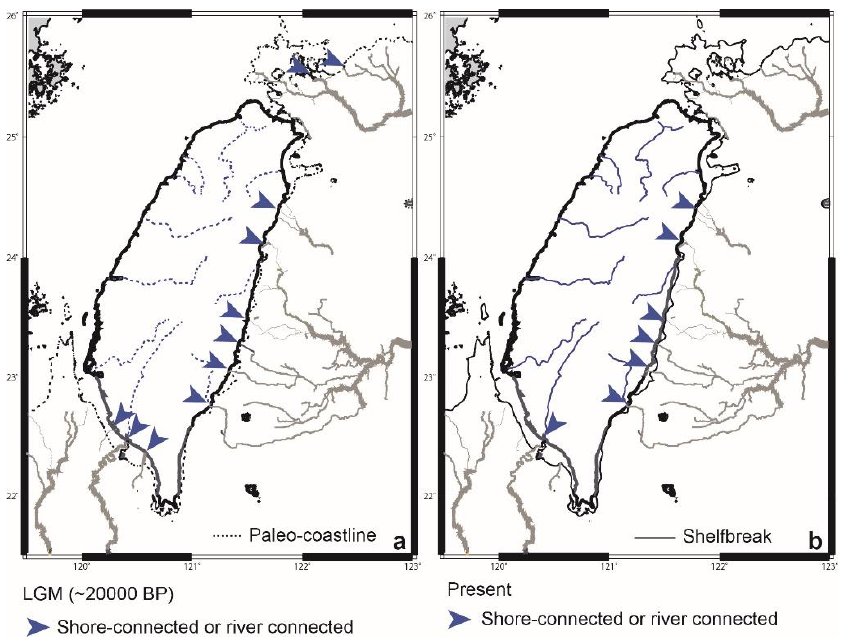
Figure 6. The hypothesized distributions of paleo-rivers and canyons in the Taiwan area since the LGM. ( a ) There were relatively large numbers ( n = 11) of shore-connected canyons in the Taiwan area during the LGM. ( b ) Seven canyons remain connected to the shore during the present sea-level highstand. Six shore-connected canyons occur on the eastern Taiwan margin and one on the SW margin.